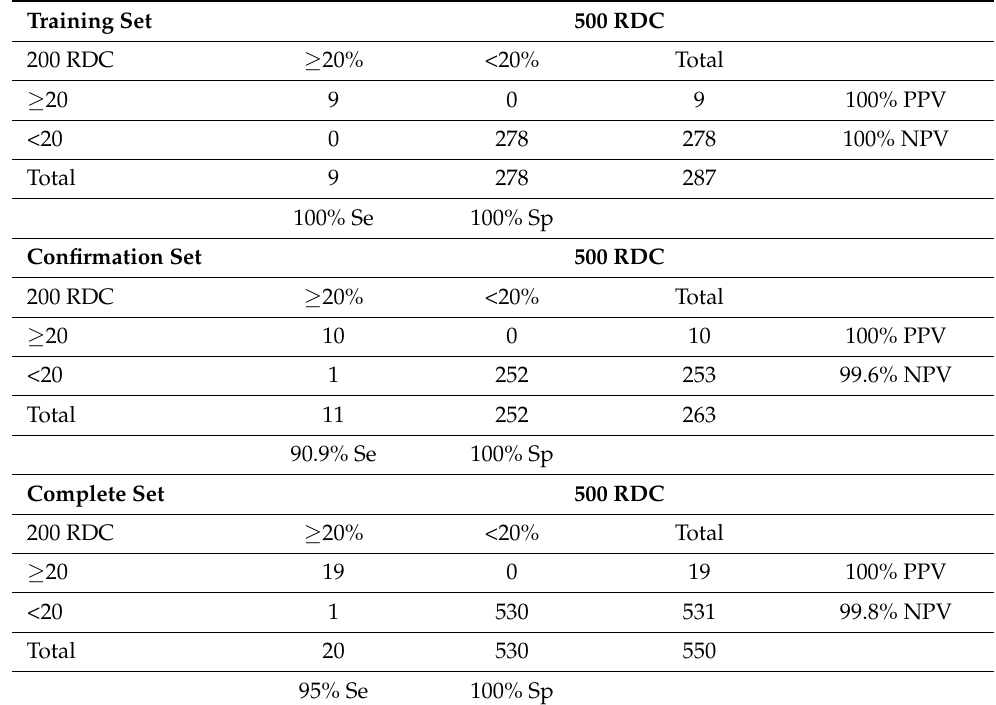
Table 6. Diagnostic performance of 200-cell DCC at the 20% blast